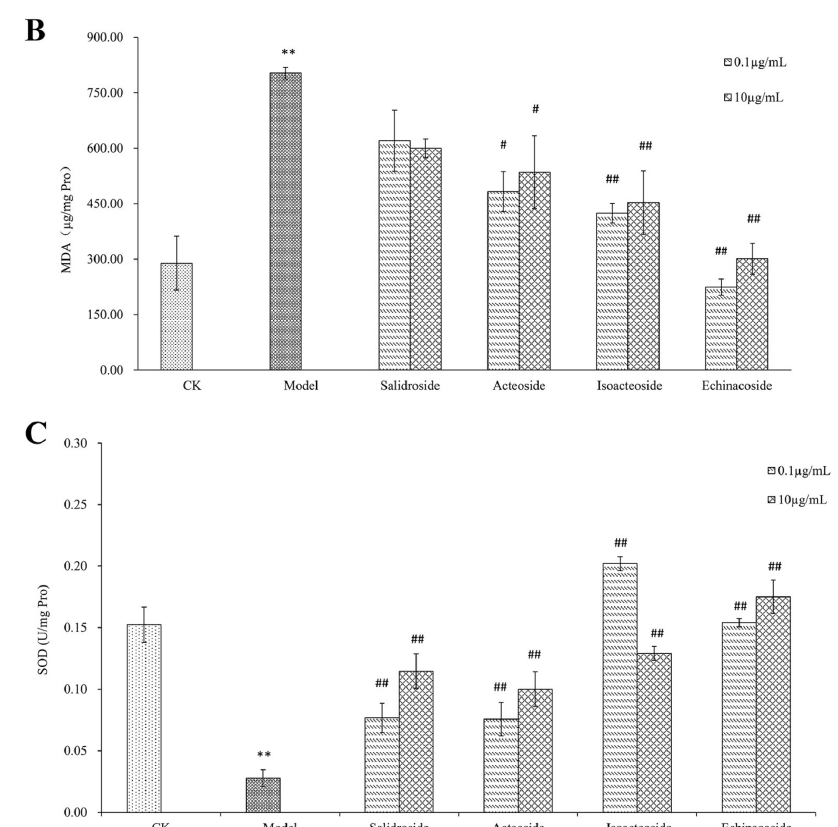
Figure 2. PhGs blocked ROS and MDA accumulation and increased the activities of SOD in PC12 cells. PC12 cells were incubated with PhGs (0.1, and 10 µ g/mL) for 24 h, and then incubated with 200 µ M H 2 O 2 for another 2 h after the PhGs were removed. ( A ) PhGs blocked ROS and MDA accumulation. ( B ) PhGs blocked MDA accumulation. ( C ) PhGs increased the activities of SOD. CK: normal group, Model: H 2 O 2 treated group, Salidroside: salidroside treated group, Acteoside: acteoside treated group, Isoacteoside: isoacteoside treated group, Echinacoside: echinacoside treated group. ** p < 0.01 versus untreated group; # p < 0.05, versus H 2 O 2 treated group, ## p < 0.01, versus H 2 O 2 treated